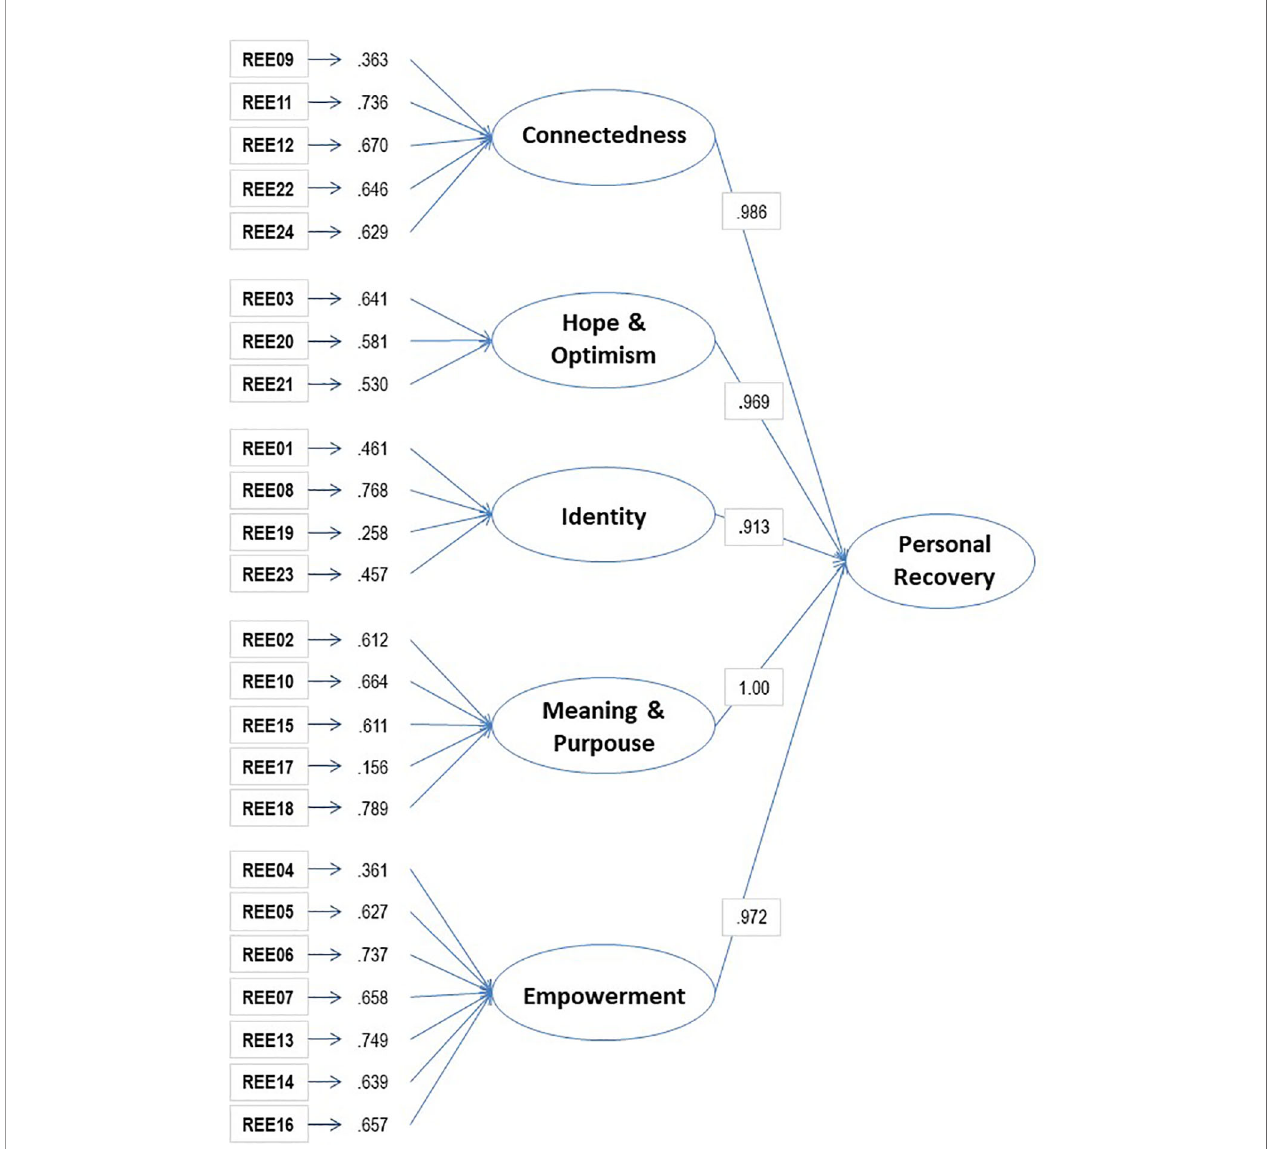
FIGURE 1 | Second order factor structure of the